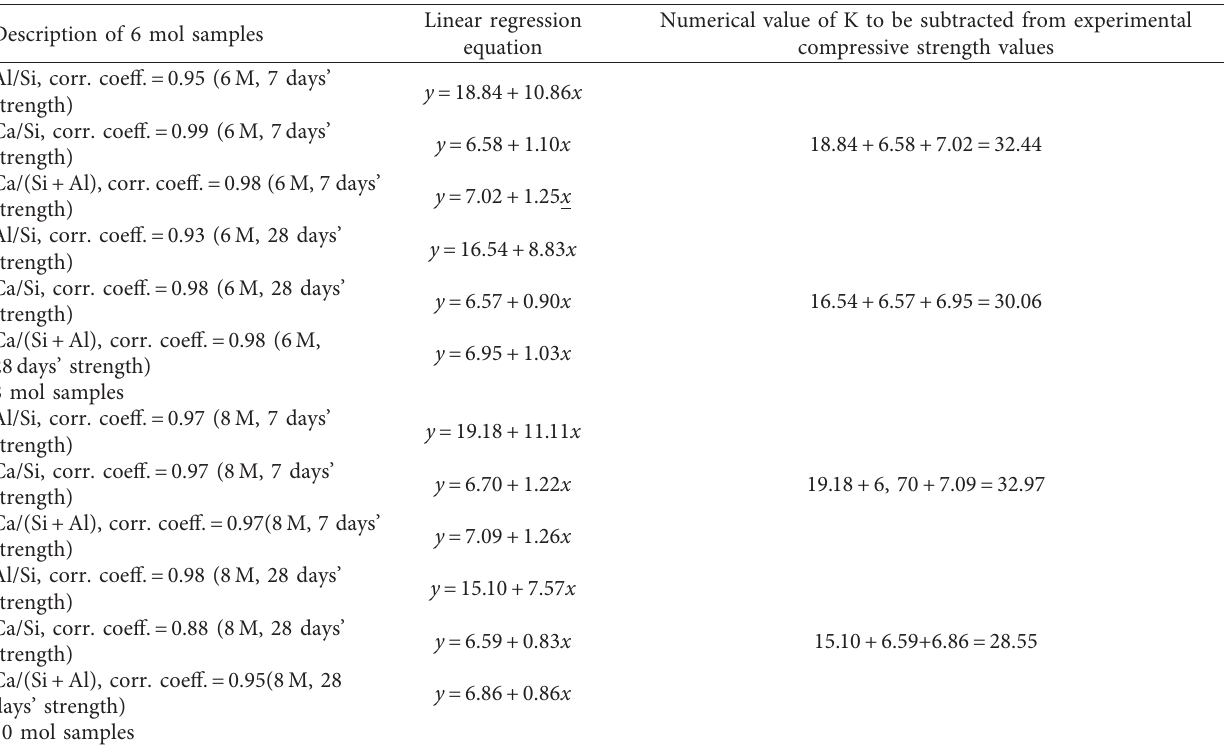
Figure 7: Correlation coefficient between experimental compressive strength and Ln, Ca/(Si + Al) ratio for 6M and 12M samples. Table 4: Determination of K values from the linear regression